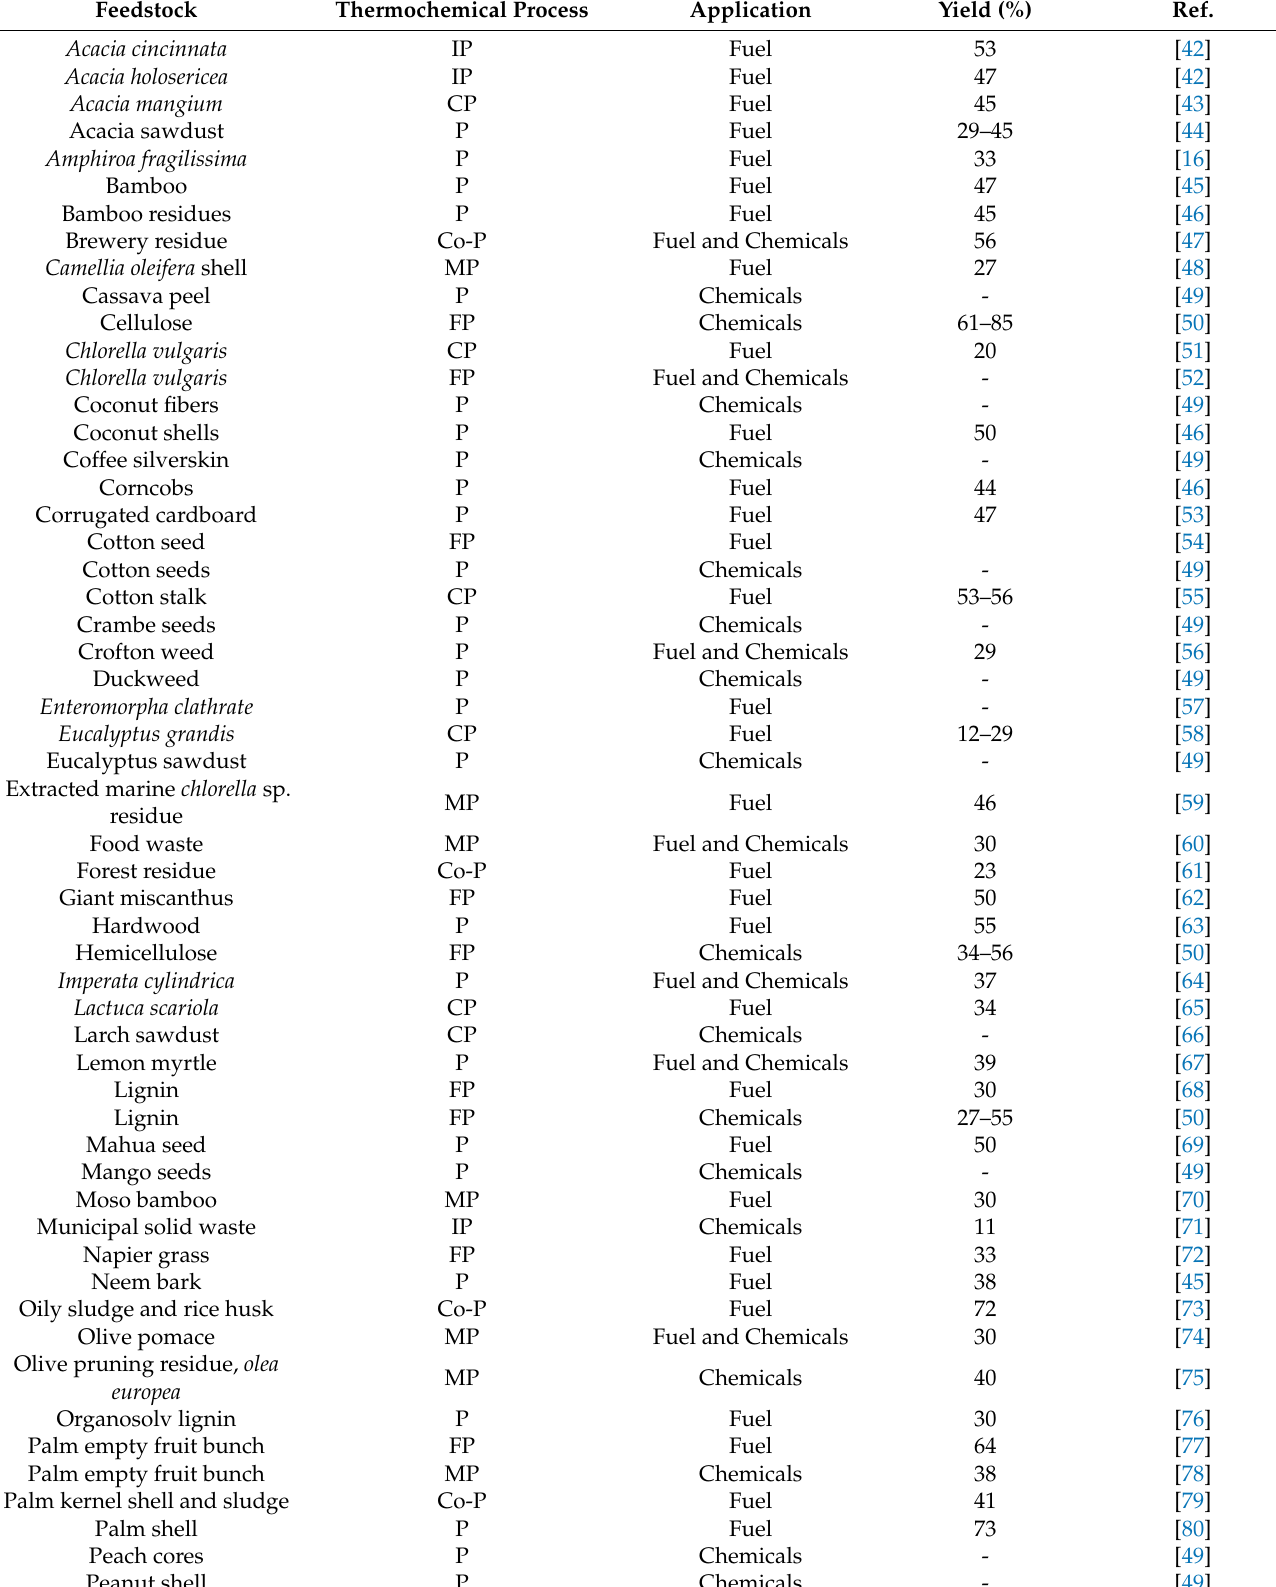
Table 2. Summary of pyrolysis bio-oil